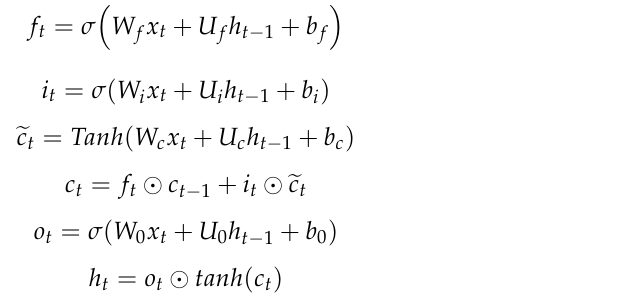
Figure 4. LSTM structure.